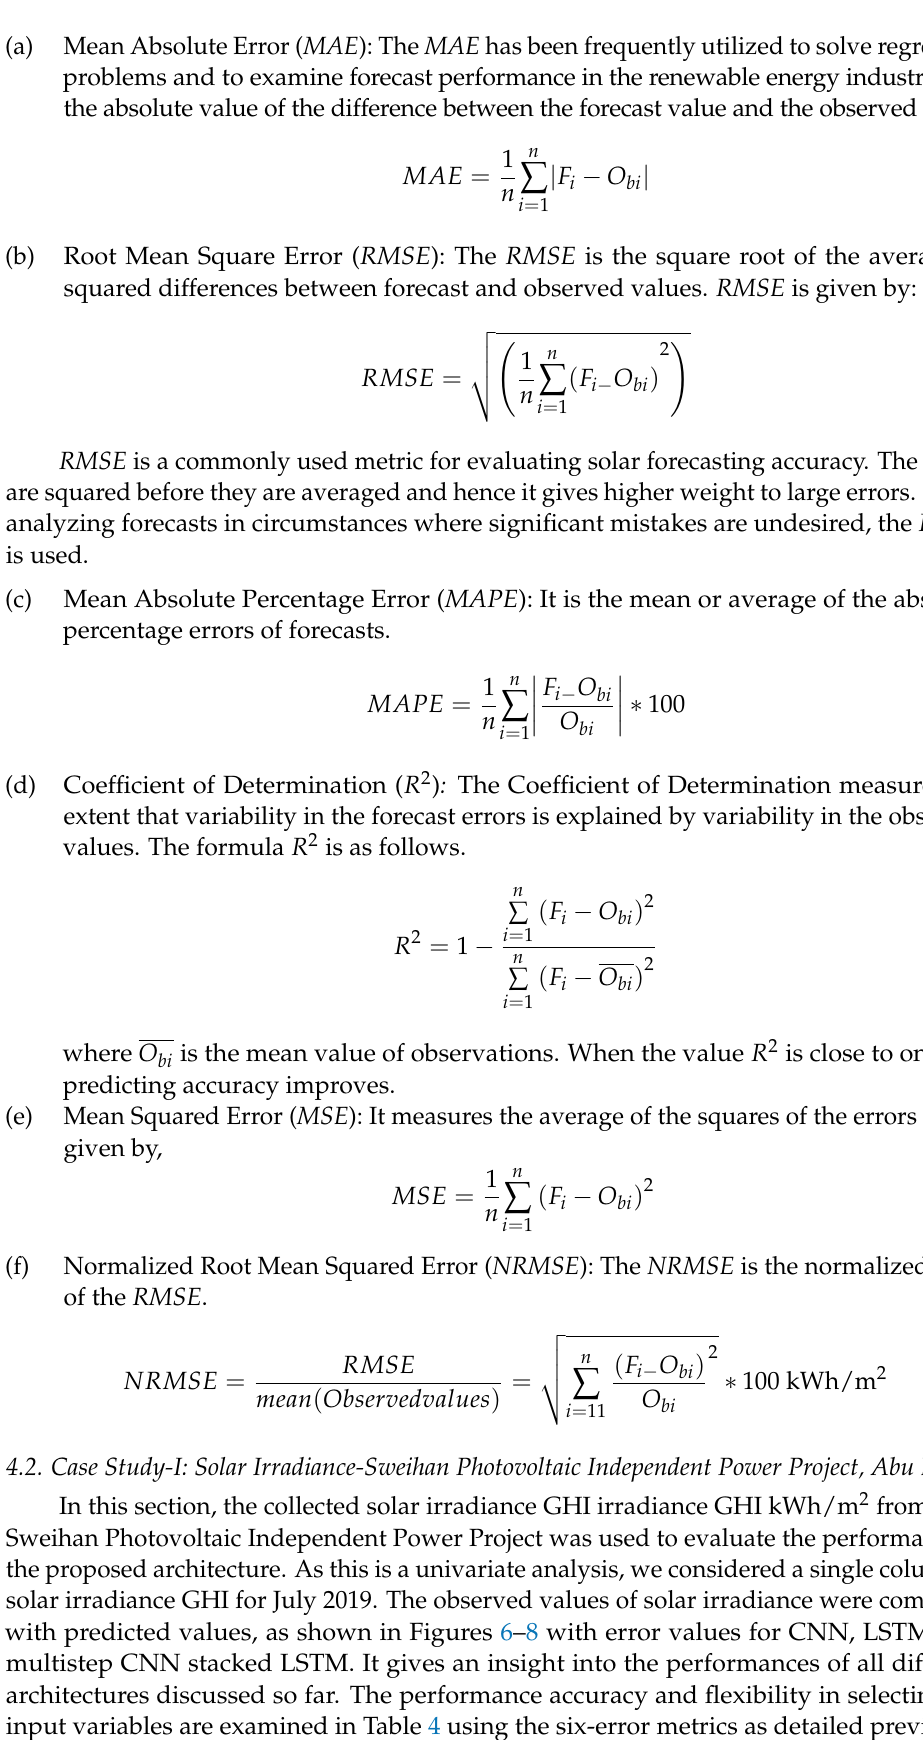
Root Mean Square Error ( RMSE ): The RMSE is the square root of the average of squared differences between forecast and observed values. RMSE is given by: